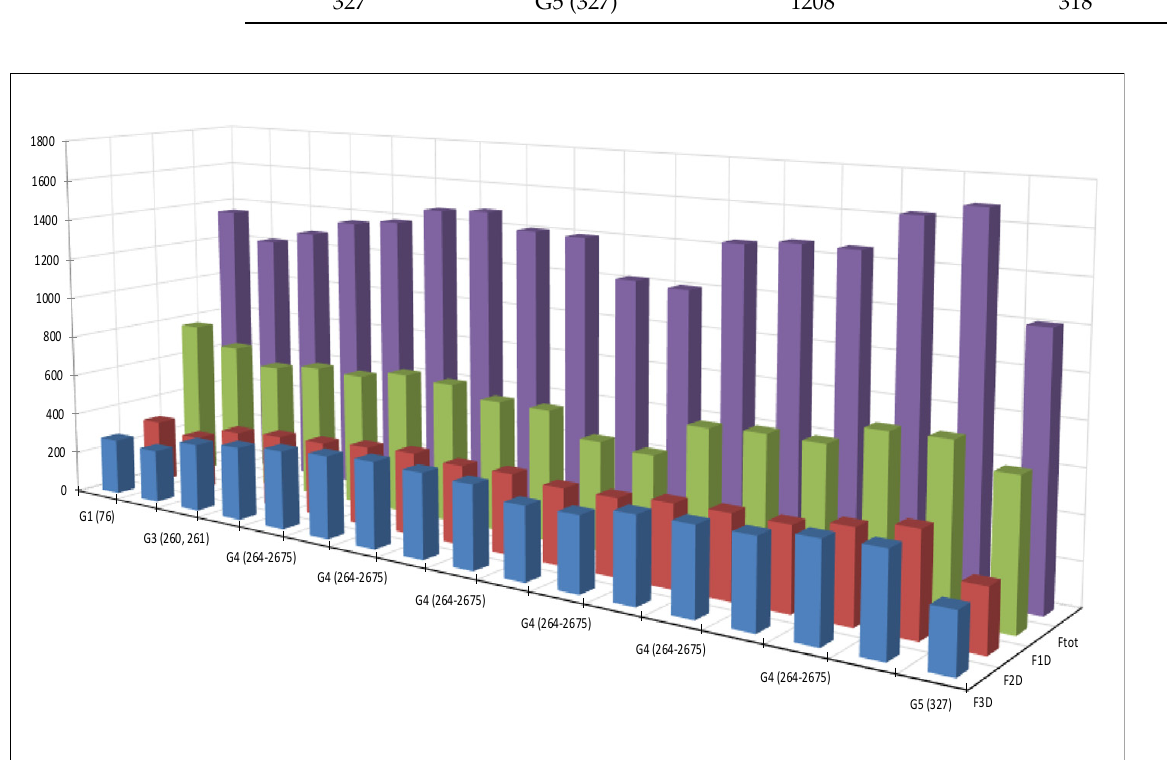
Figure 21. Repartition of the water supply ratios related to leak events. Table 12. Repartition of the water supply ratios related to leak events.